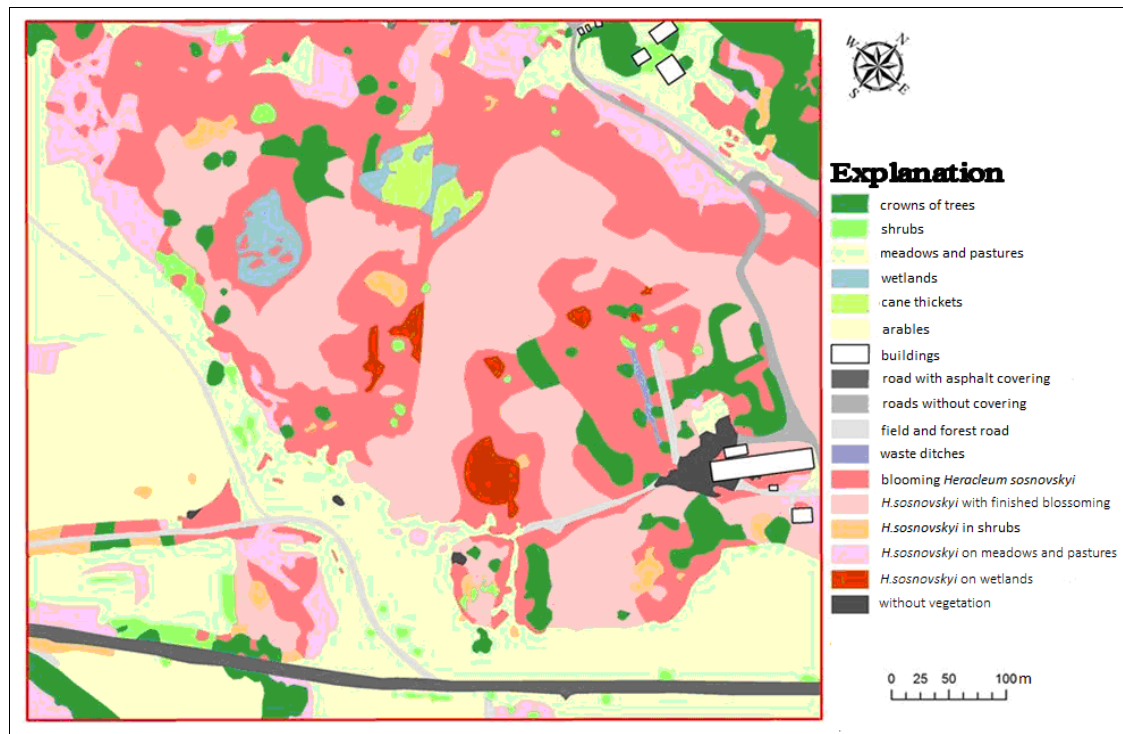
Fig. 4. The spread of H. sosnovskyi near Yavora village (July 2016) (Shtoiko,